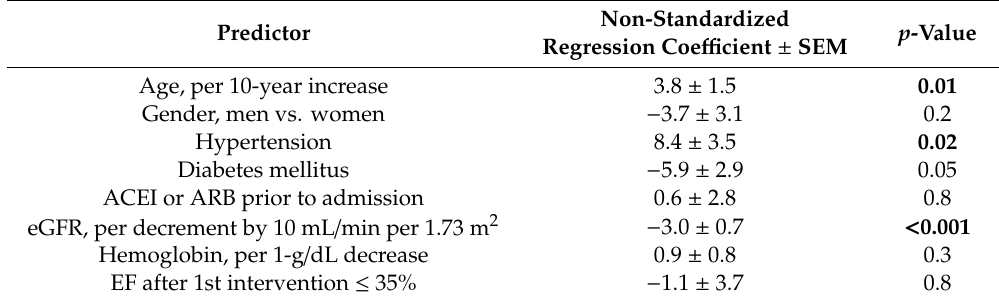
Table 5. Multiple linear regression analysis of the predictors associated with relative creatinine changes after the 1st